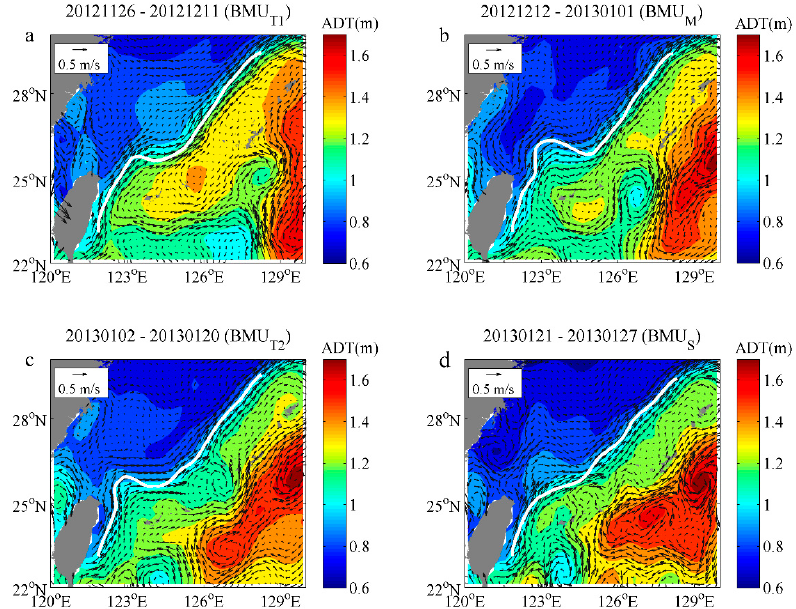
Figure 13. Color filled contours represent ADT in m from November 26, 2012 to January 27, 2013 in the northeast of Taiwan Island. The period is divided into four parts: from November 26 to December 11, 2012 ( a ), from December 12, 2012 to January 1, 2013 ( b ), from January 2 to January 20, 2013 ( c ) from January 21 to January 27, 2013 ( d ). The vectors represent the geostrophic currents in m / s. White curves denote the Kuroshio surface axis corresponding to the four